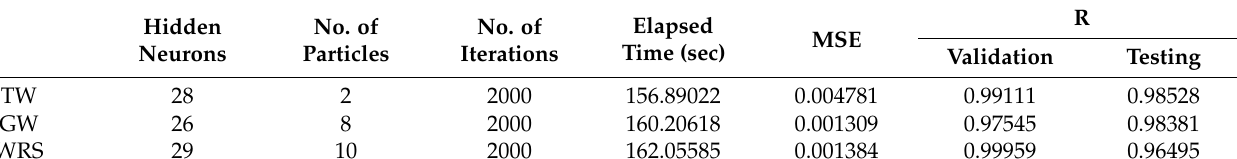
Table 12. NN-PSO simulation results for the NPI mapping of domestic water samples.